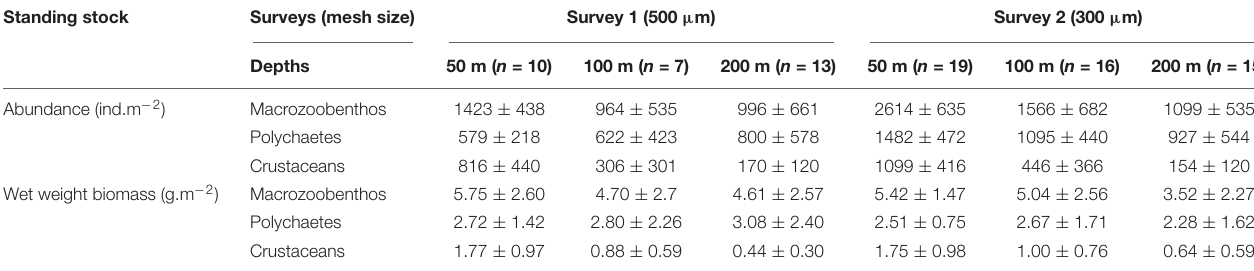
TABLE 2 | Density (ind.m − 2 ) and wet weight biomass (g.m − 2 ) of macrozoobenthic groups at each depth strata [mean ± SD, n = No. of samples]. Standing stock Surveys (mesh